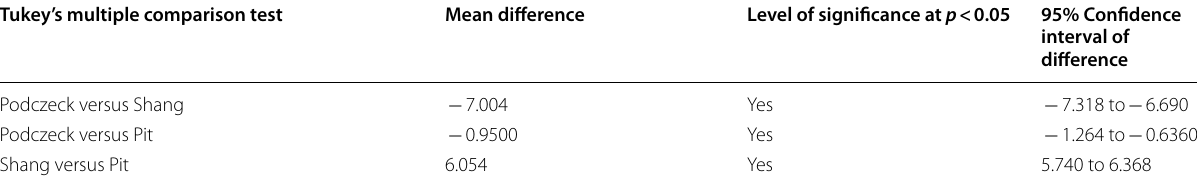
Table 2 Multiple comparison test for a sample compaction data Tukey’s multiple comparison test Mean